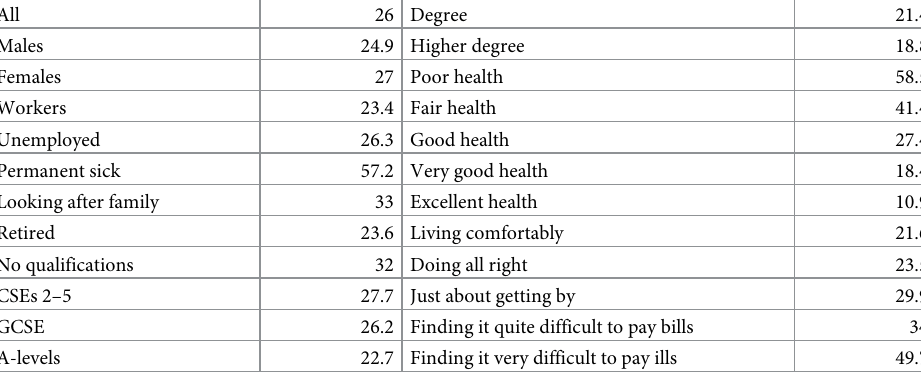
Table 9. Incidence (%) of back pain symptoms in NCDS at Age